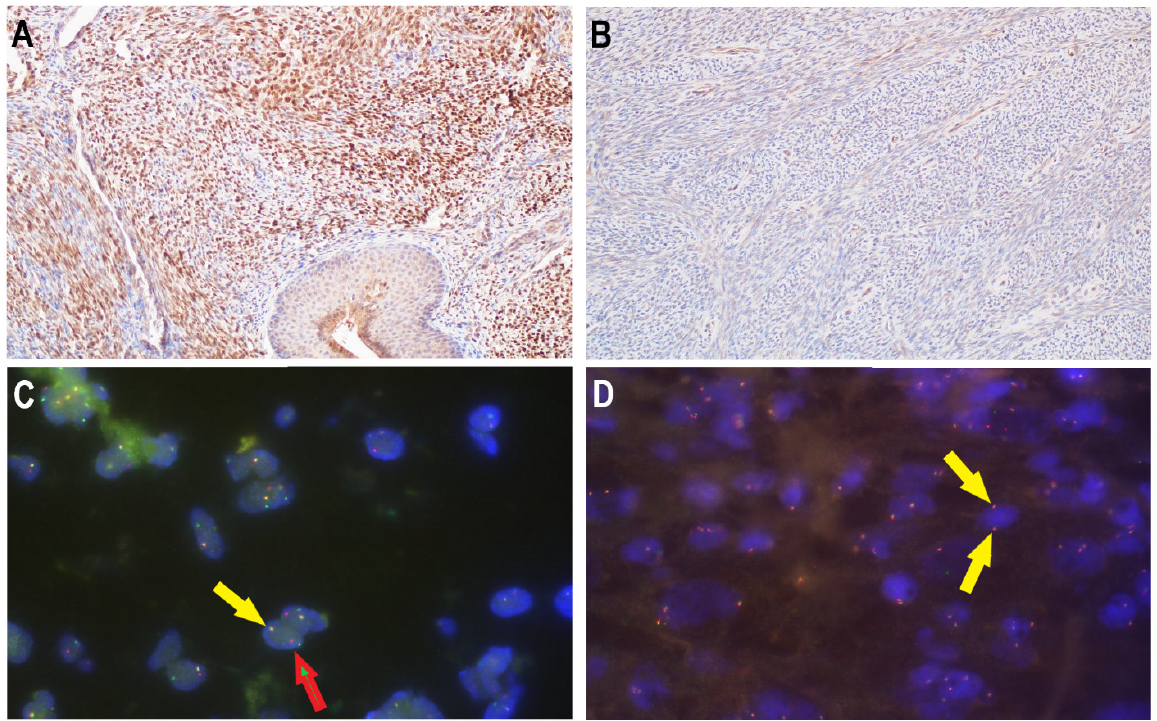
Figure 3. PAX3 rearrangement. PAX3 expression IHC ( A , B ). Diffuse, strong nuclear staining was seen and the expression was distinctly stronger than the surrounding background ( A ). In PAX3 negative cases, only no specific background expression was observed ( B ). PAX3 rearrangement by FISH ( C , D ). The yellow arrows indicate signals of an intact PAX3 gene region and the separate red and green signals (red/green arrow) represent positive nuclei with PAX3 gene break ( C ). Table 3. IHC and FISH findings in incisional biopsy and resection specimens.